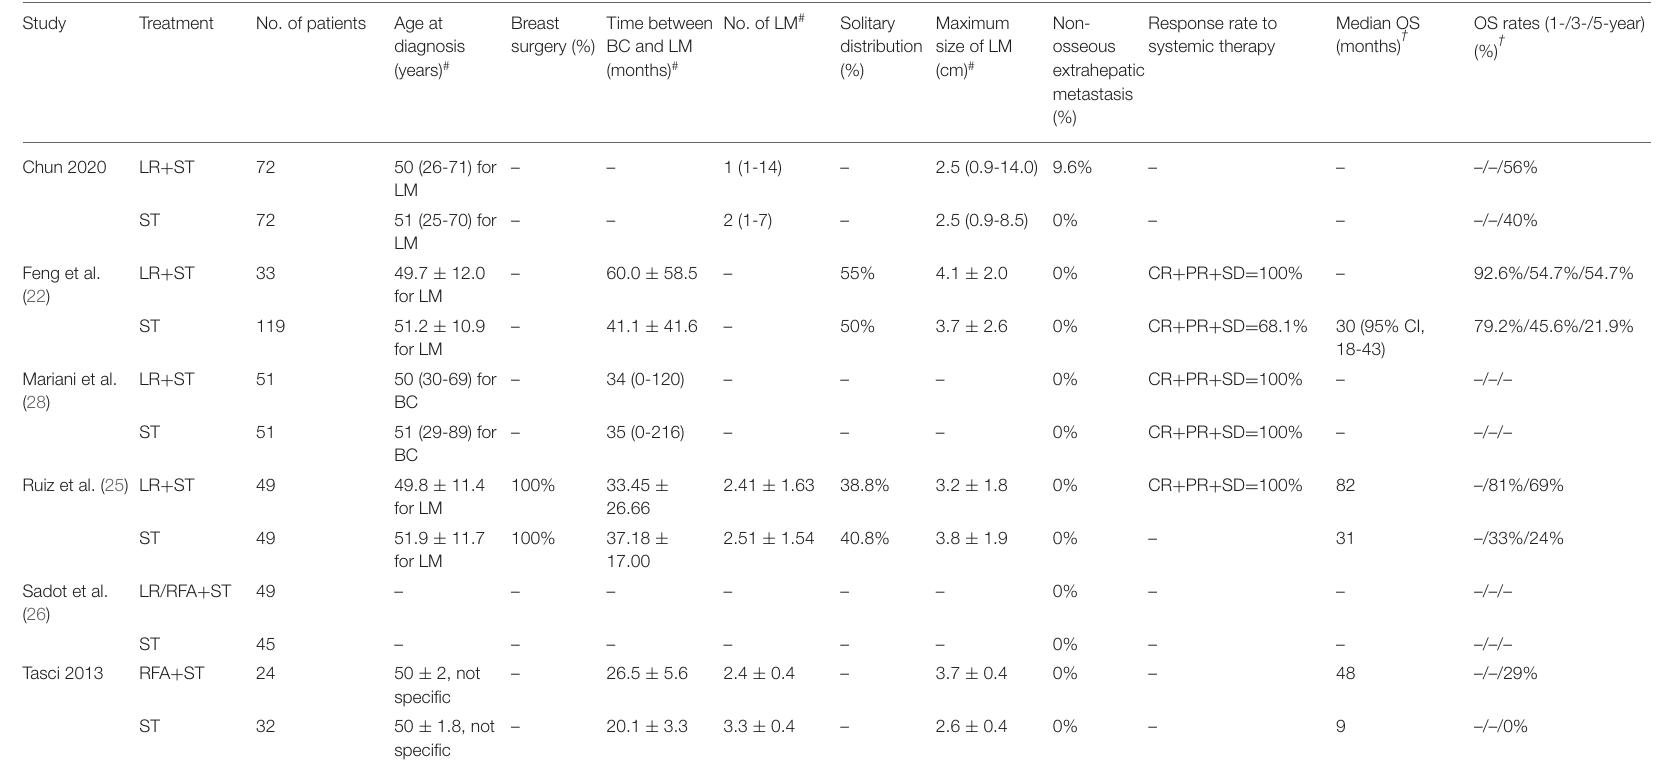
TABLE 3 | Characteristics of patients with breast cancer liver metastases in the matched